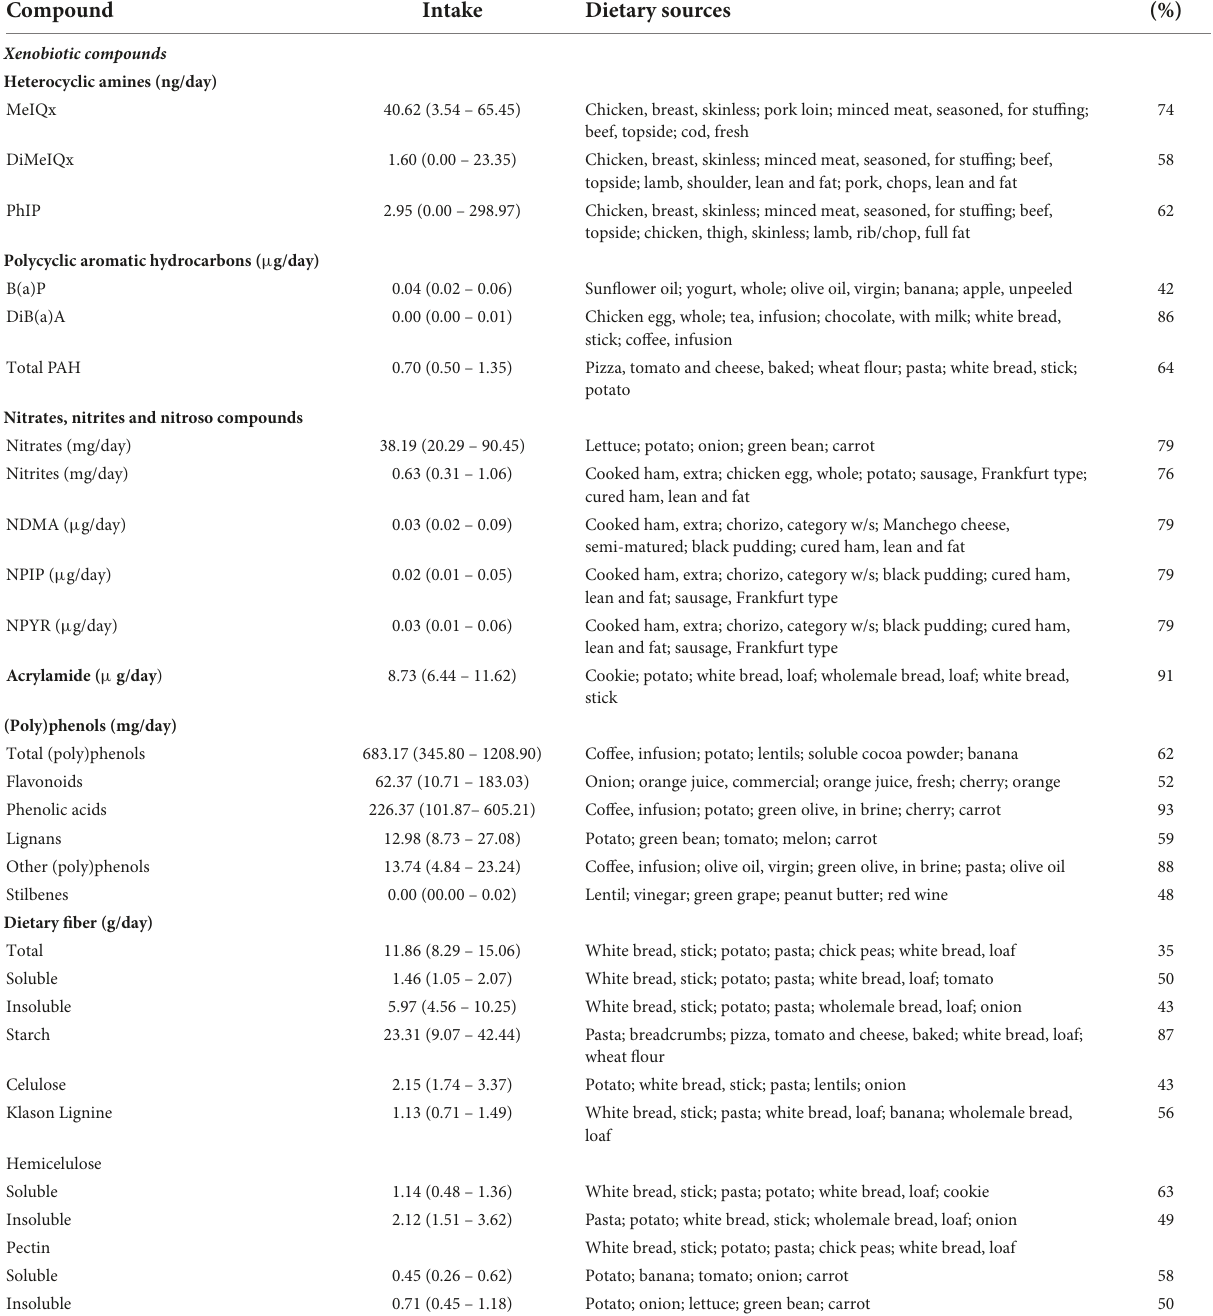
TABLE 3 Top dietary sources of xenobiotics (poly)phenols and fibers in the sample of study. Compound Intake Dietary sources Xenobiotic